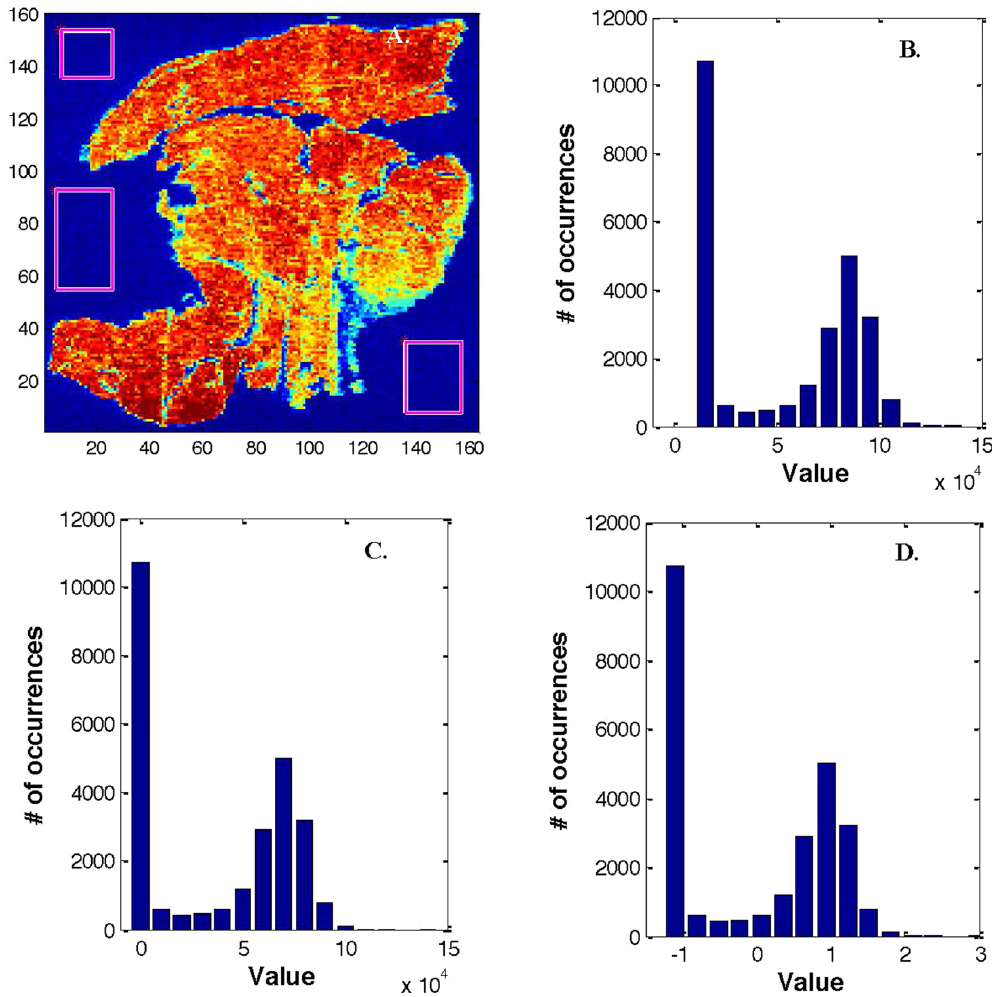
Figure 3. Illustration of the process followed for background subtraction. A. the rectangles represent the areas selected to be used as background in this 13 C image. In this example, 1918 spectra were included in the rectangles and their mean was subtracted from all spectra. B. intensity distribution before subtraction of the background, C. intensity distribution after subtraction of the background, D. intensity distribution after subtraction of the mean and division by the standard